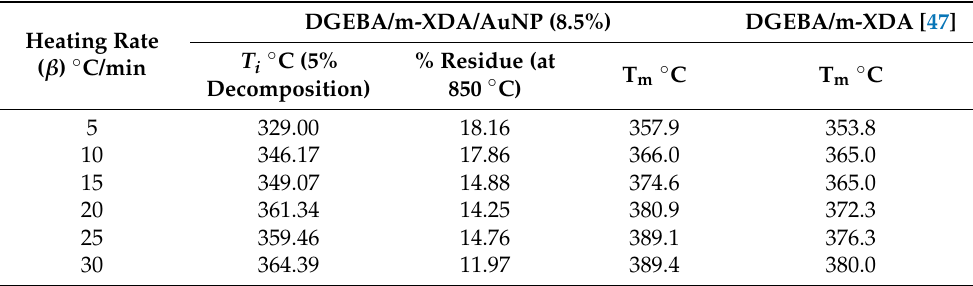
Table 4. Degradation parameters at different heating rates of the system DGEBA/mXDA/AuNP (8.5%) nanocomposite.